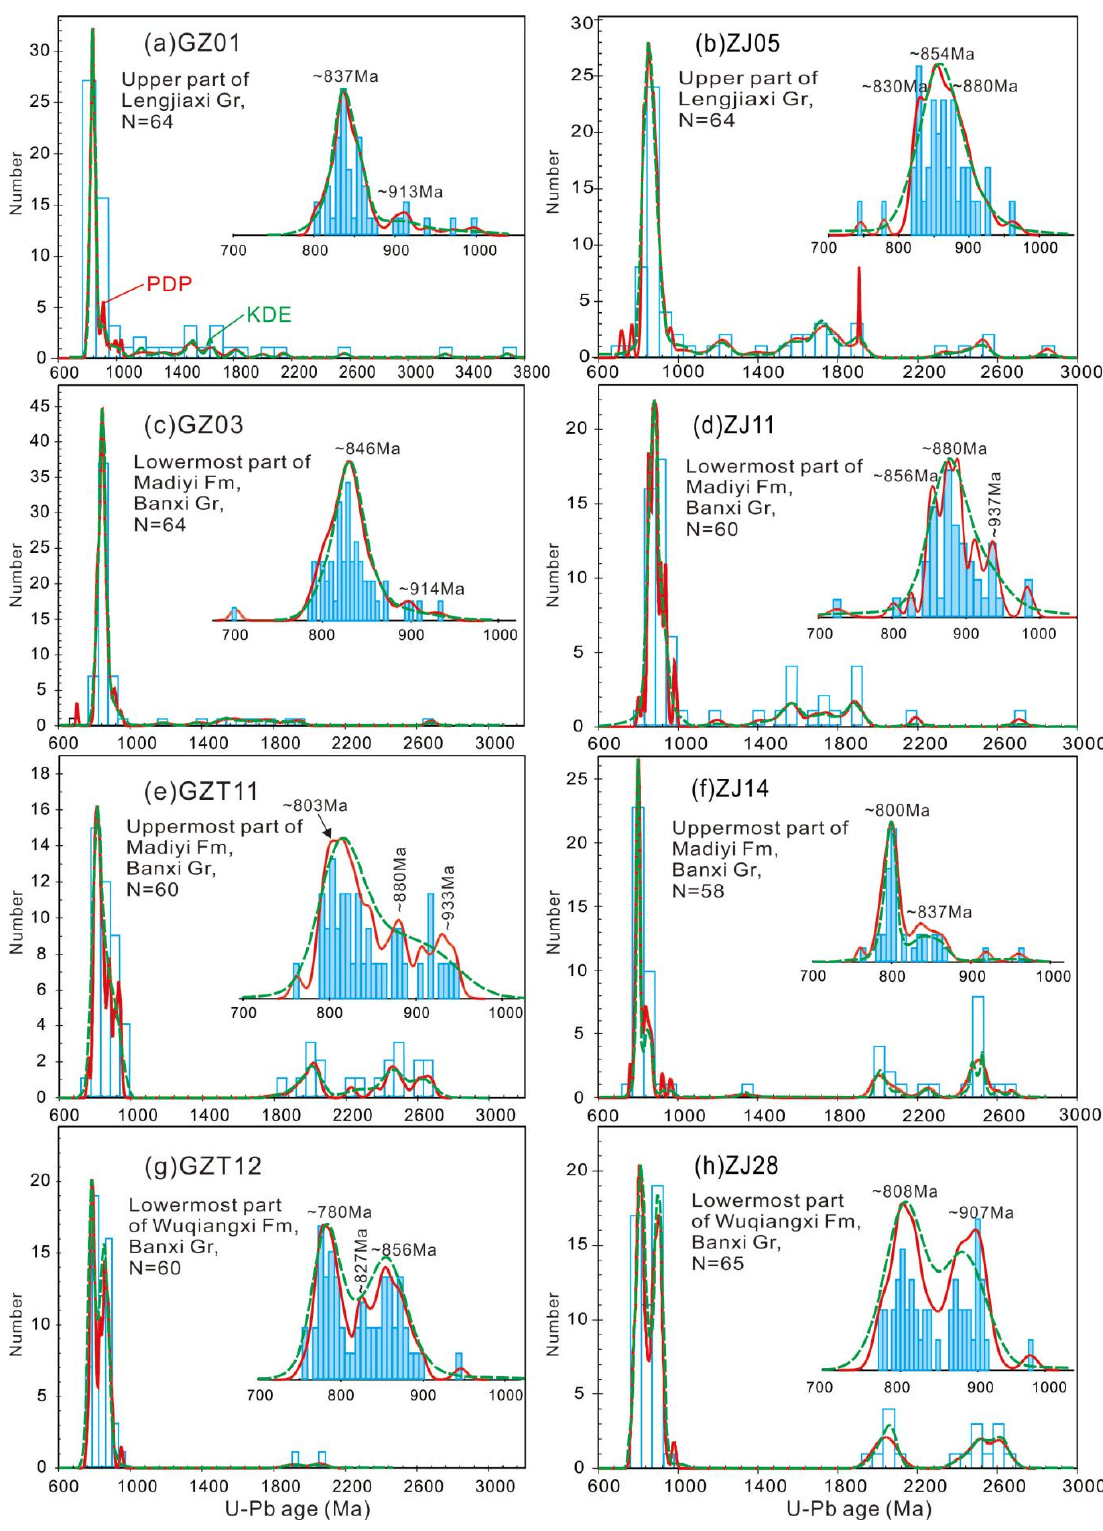
Figure 6. Relative probabilities of detrital zircons from studied samples GZ01 ( a ), ZJ05 ( b ), GZ03 ( c ), ZJ11 ( d ), GZT11 ( e ), ZJ14 ( f ), GZT12 ( g ) and ZJ28 ( h ) in Guzhang and Zhijiang areas of the WJO. PDP—Probability Density Plot; KDE—Kernel Density Estimation. 207 Pb/ 206 Pb ages are used for zircons with ages >1000 Ma, 206 Pb/ 238 U ages are used for zircons younger than 1000 Ma.